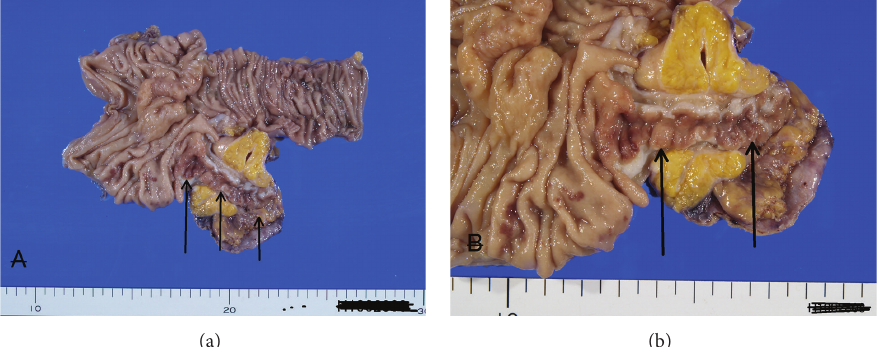
Figure 3: Gross features of the appendiceal tumor. (a) The appendix (arrow) is open. (b) High power view of the appendix. The appendiceal mucosa (arrows) shows